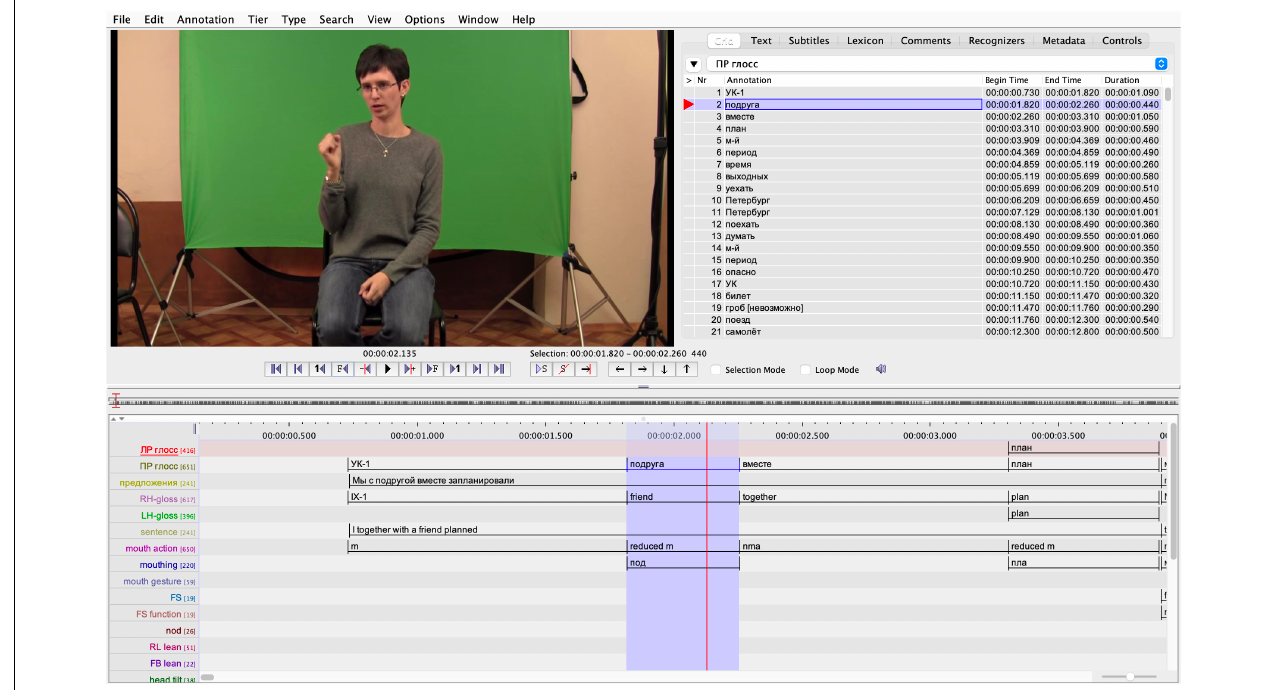
FIGURE 1 | ELAN screenshot. Reproduced with permission from Svetlana Burkova (Novosibirsk State Technical University), available at the online corpus of Russian Sign Language,